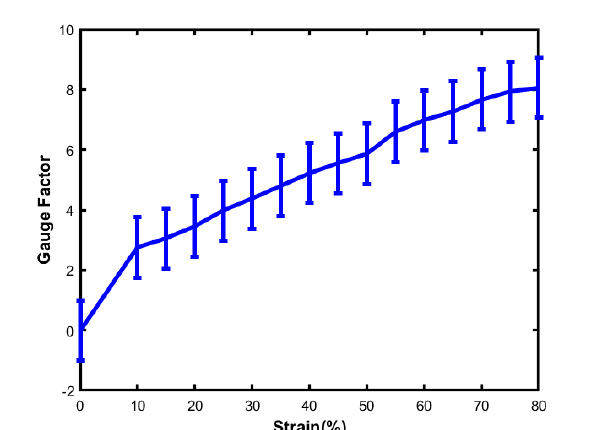
Figure 8. The relationship between the gauge factor and